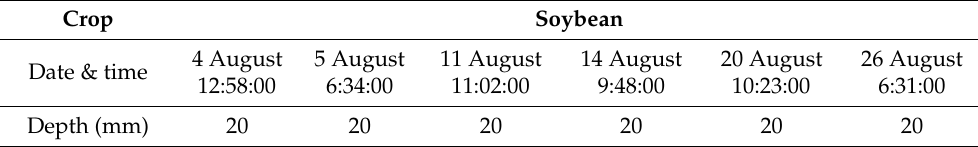
Table 1. Irrigation dates and depths during the growing stages, August